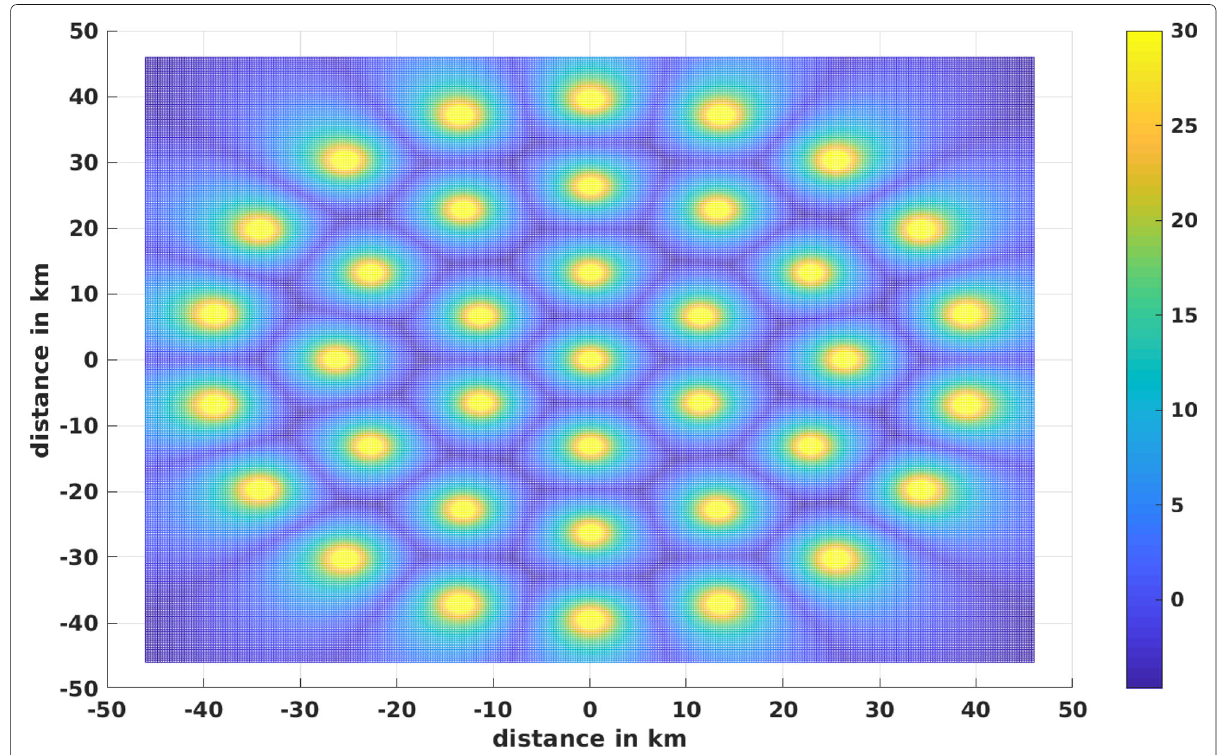
Fig. 8 SINR heatmap of 37 cell terrestrial rural deployment